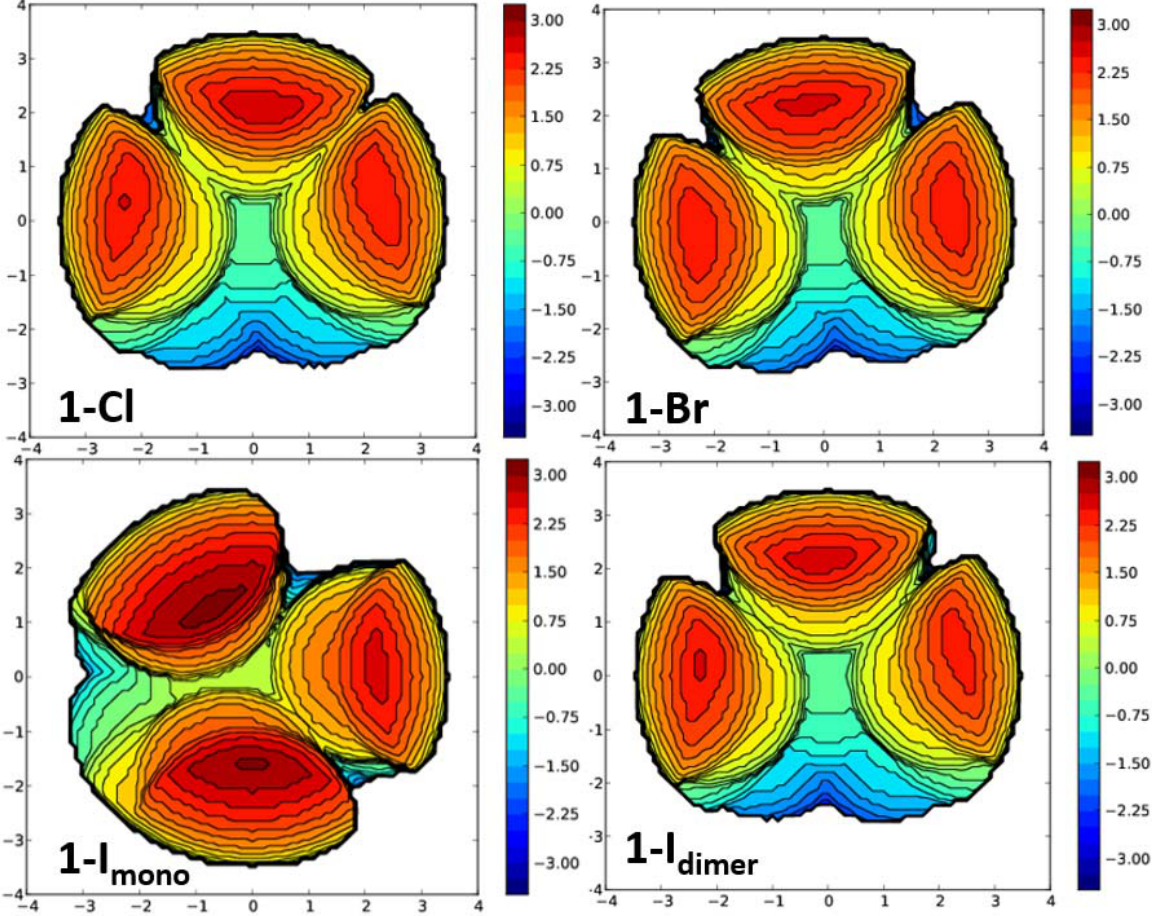
Figure 9. Steric map of the Tptm in 1-X (dimeric, clockwise from top left: X = Cl, Br, I), and monomeric 1-I (bottom left). Generated from buried volume calculations with a coordination sphere of 3.5 Å.